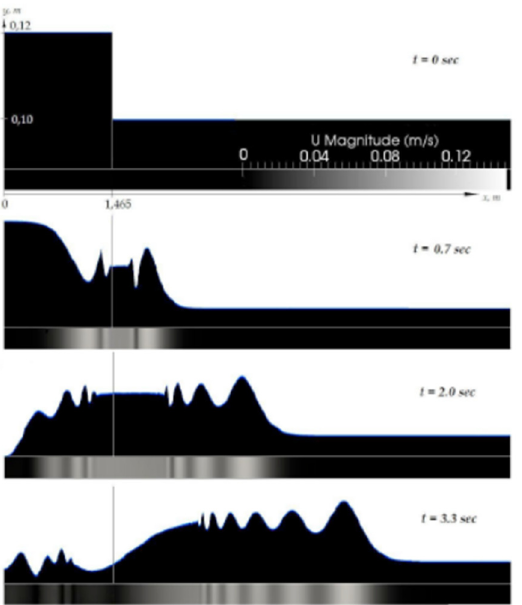
Figure 5. Modeling the process of generating a tsunami-type wave in a wave flume by an ideal generator at H = 0.103 m, A/H = 0.1.